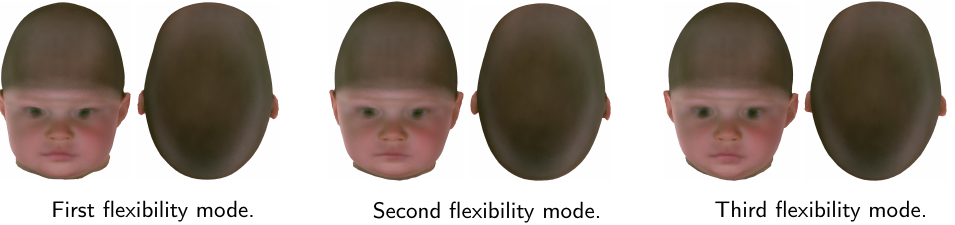
Figure 9. The first three flexibility modes with fixed cranium, applied to a synthetic scaphocephaly patient. Changes are minimal for the cranium and maximal for the face, neck, and